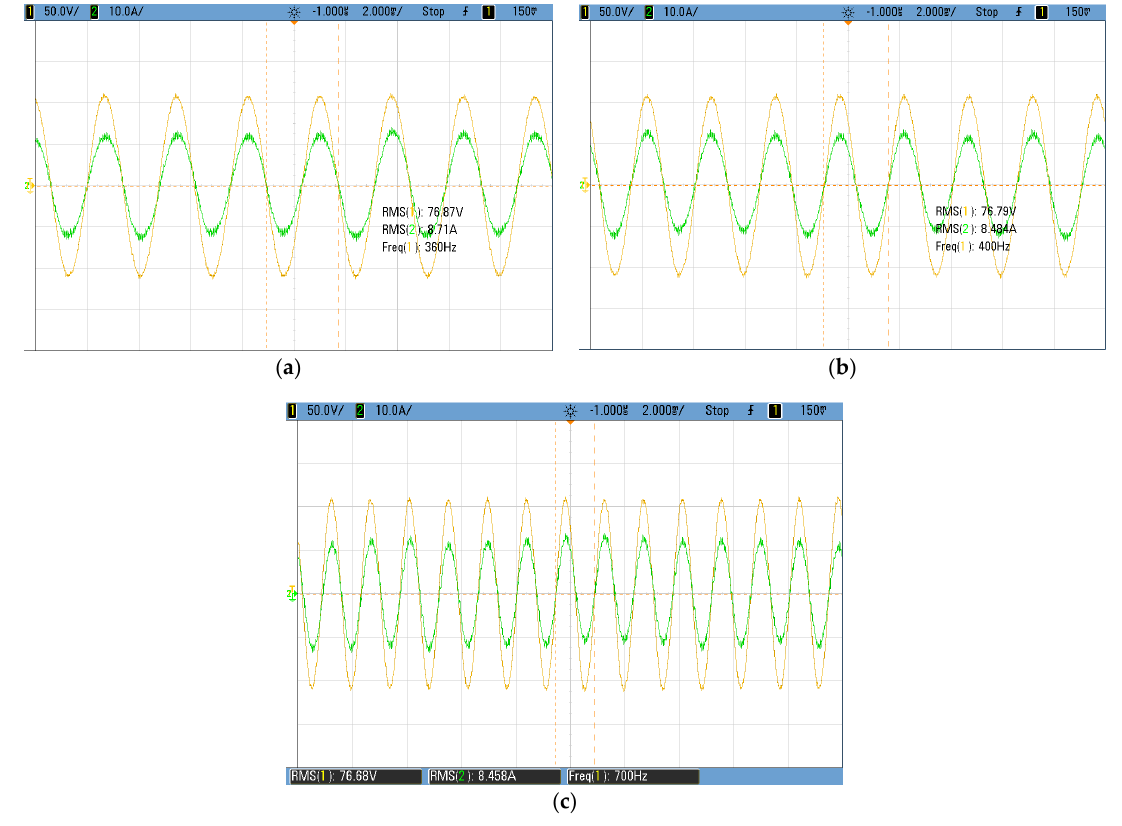
Figure 17. Variable frequncy operation in rectifier mode ( a ) 360 Hz; ( b ) 400 Hz; and ( c ) 700 Hz.